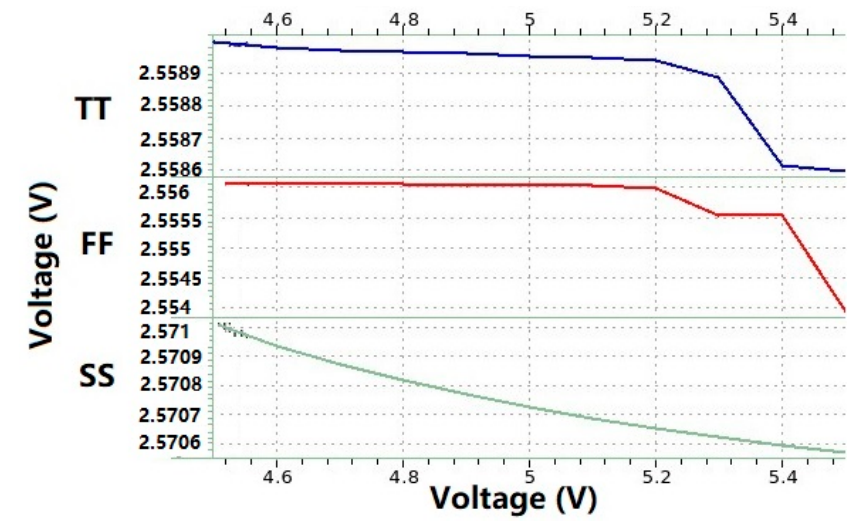
Figure 11. Power supply rejection ratio (PSRR) simulation results of proposed SPWBGR.